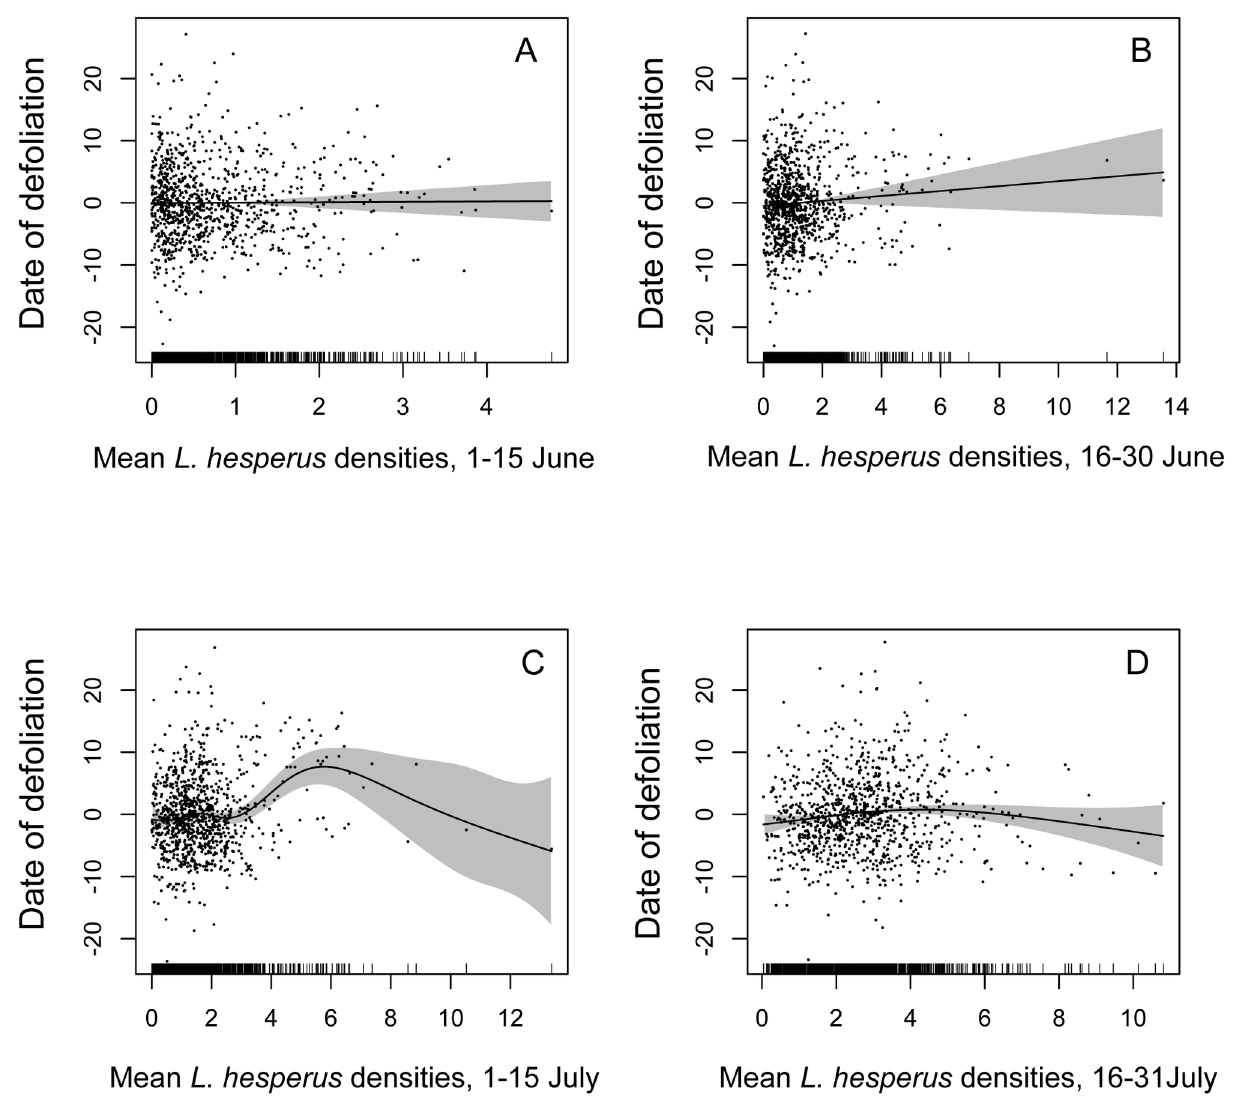
Figure 3. Crop termination and L . hesperus density. Association between the date of the first application of a defoliant to the cotton crop (expressed as a deviation from the year’s mean date of initial defoliant treatment) and mean L . hesperus densities observed during (A) 1-15 June, (B) 16-30 June, (C) 1-15 July, and (D) 16-31 July. The solid lines are the smooths from the GAM models, and the shaded regions are the 95% confidence intervals. Positive values for the date of defoliation indicate dates later than the mean for that year. Note that because the GAM penalizes the second derivative of the fitted curve, the model collapses to linearity when evidence for non-linearity is sufficiently weak, as is seen in panel (B). See Table S2 for the GAM summary. doi: